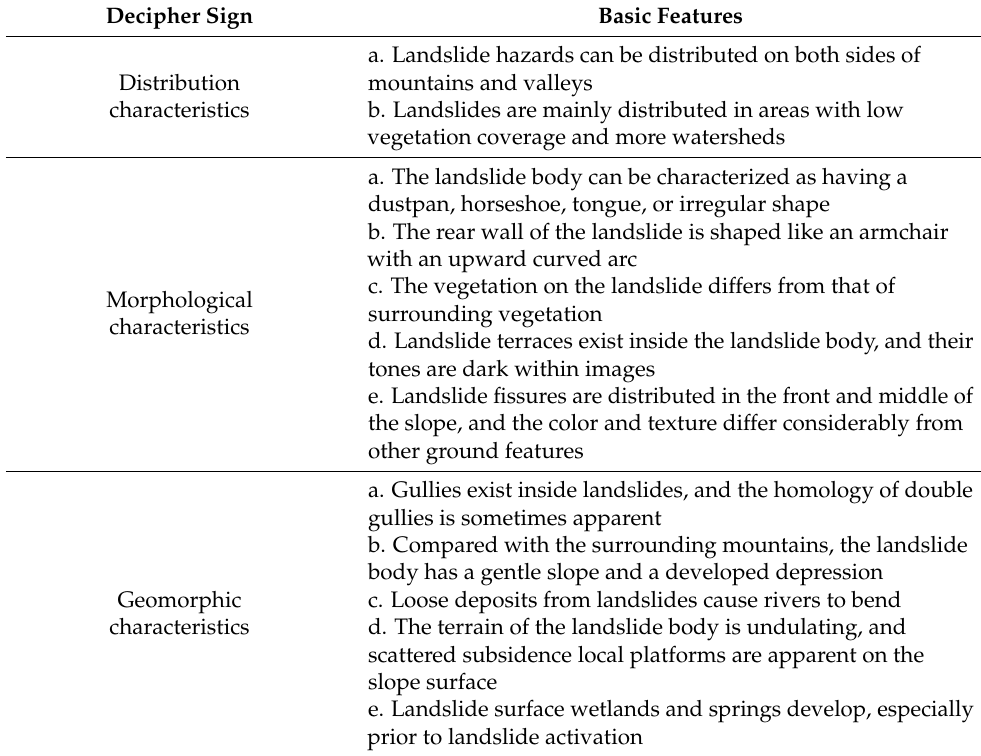
Table 2. Optical image remote sensing interpretation